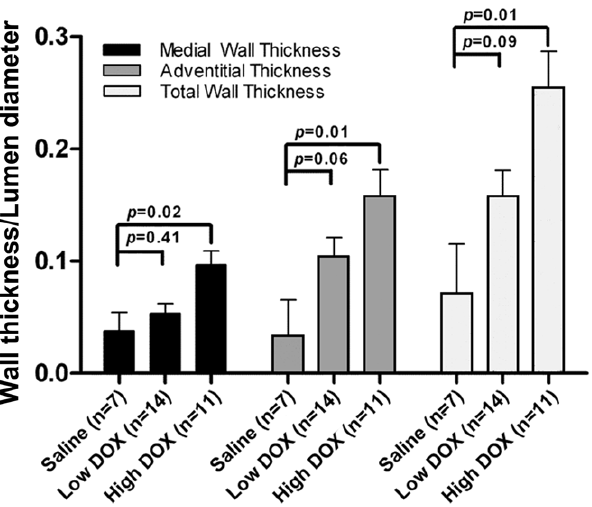
Figure 3. Adjusted medial, adventitial, and total wall thickness. These data summarize the effect of saline (n=7), low (1.5 mg/kg to 1.75 mg/kg, n=14) or high (2.5 mg/kg, n=11) doses of doxorubicin (DOX) on coronary arteriolar medial, adventitial, and total wall thickness after normalization to lumen diameter and adjusting for animal age, weight, and duration of treatment. Data shown are adjusted mean 6 the standard error of the mean (SEM). P-values are provided for comparisons between saline and doxorubicin treated groups (analysis of covariance).